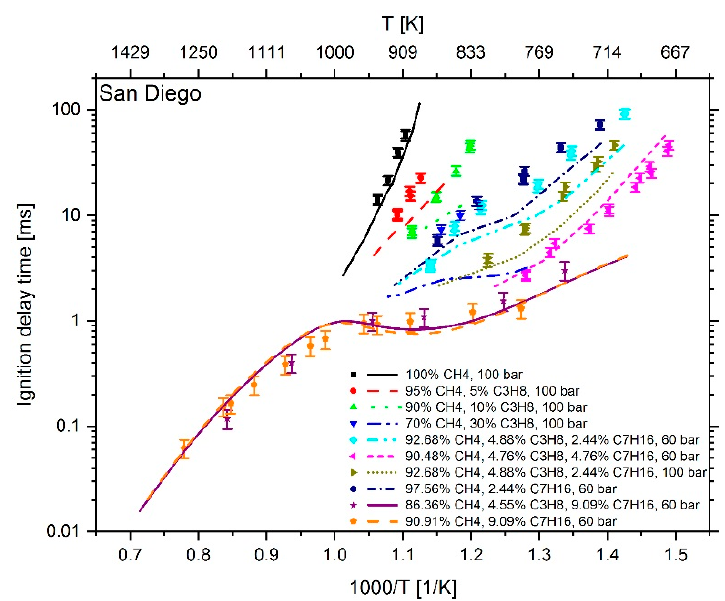
Figure 7. Experimental data (symbols) [6,7] versus model prediction (lines) using the Complete San Diego mechanism with n -heptane extension [20].